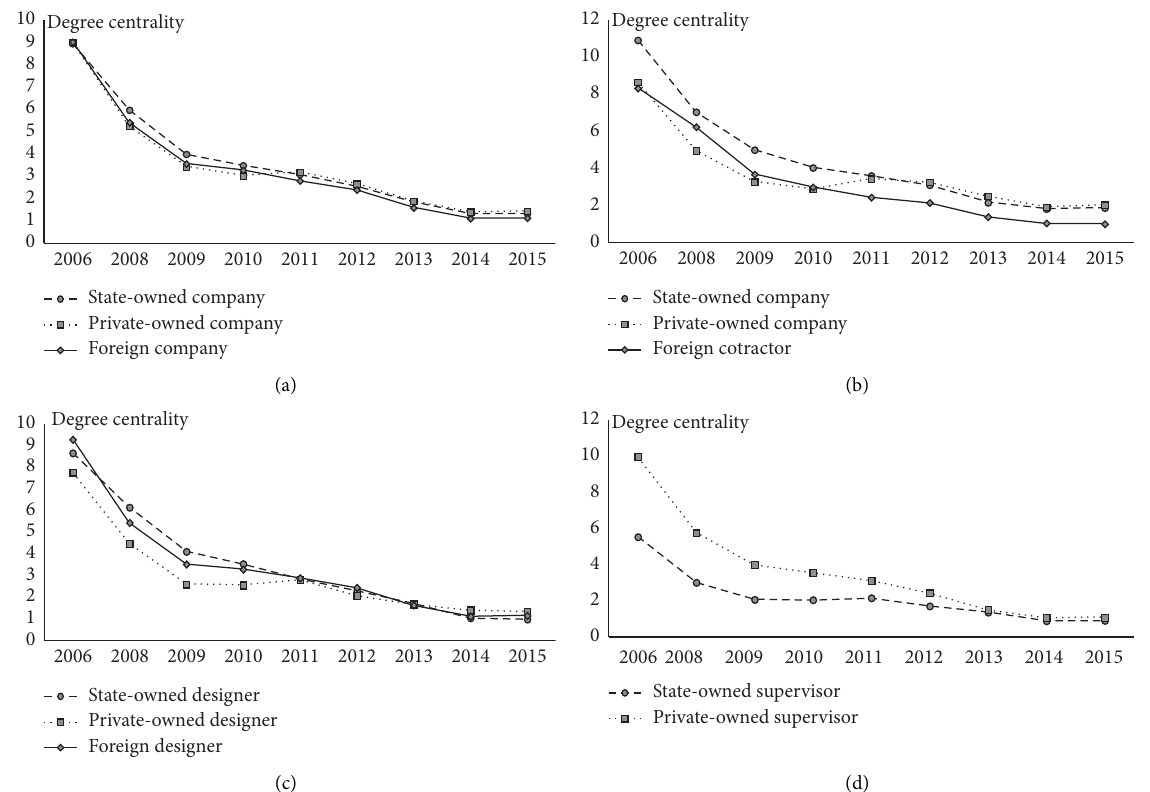
Figure 8: Trends of average degree centrality of different types of organisations, including (a) all organisations, (b) contractors, (c) designers, and (d) supervisors.